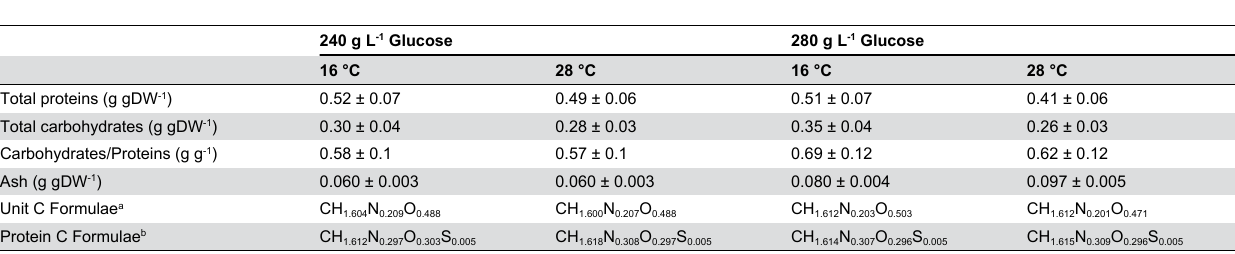
Table 2. Elemental and macromolecular composition of the biomass in the four conditions used in the present